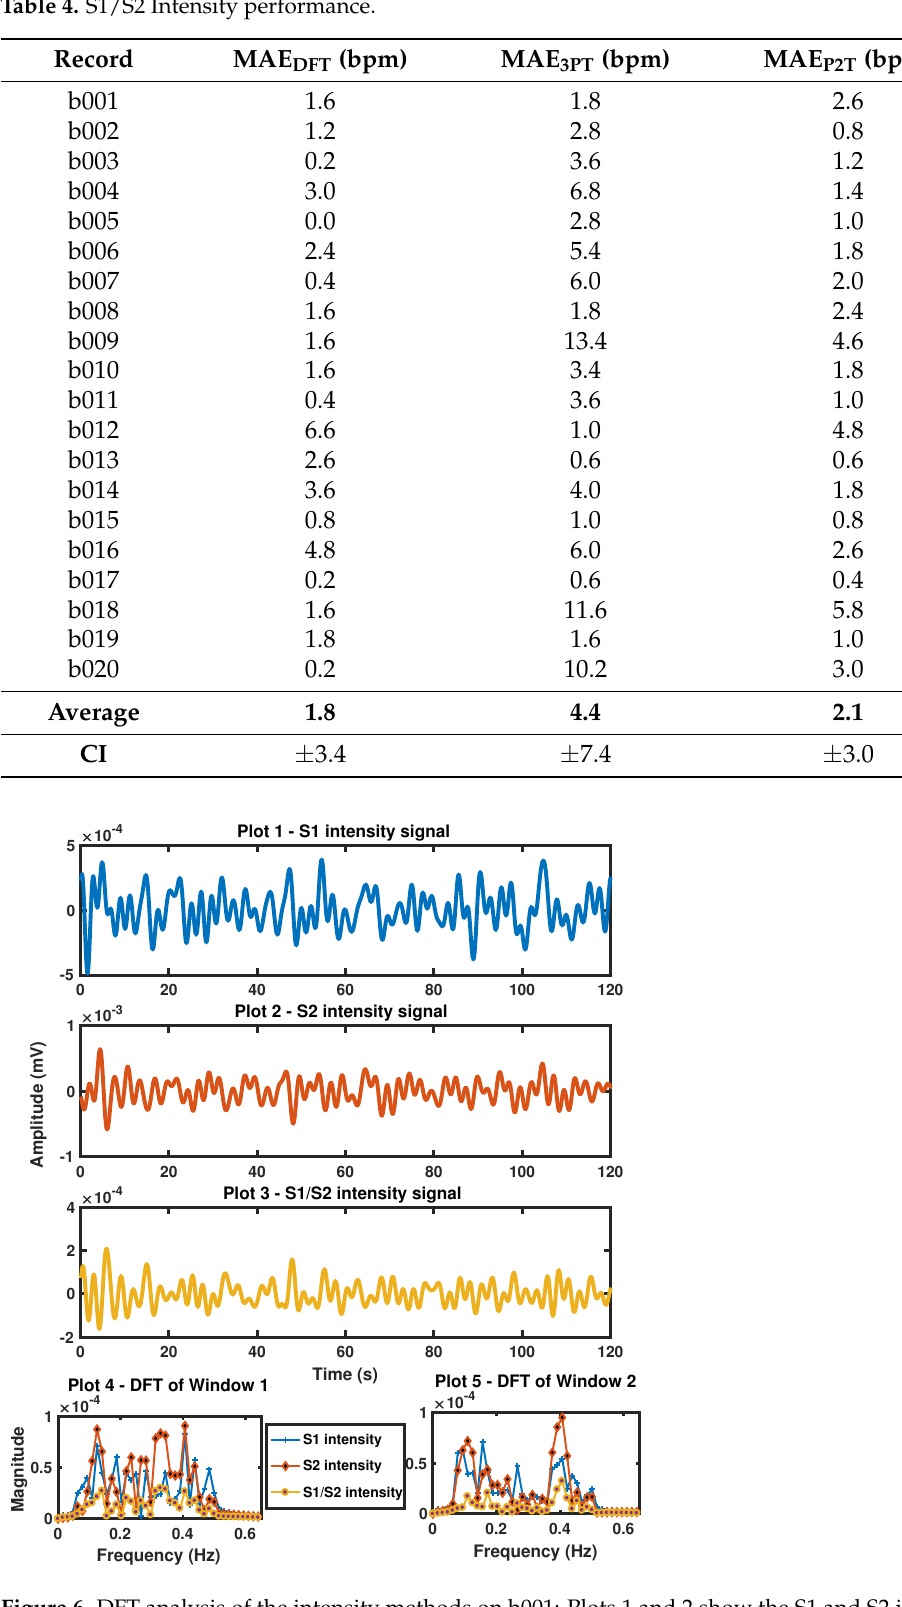
Figure 6. DFT analysis of the intensity methods on b001: Plots 1 and 2 show the S1 and S2 intensity signals, respectively. Plot 3 depicts the S1/S2 intensity signal. Plot 4 shows the DFT analysis of the three methods for the first respiratory window, where Plot 5 gives the corresponding information for the second respiratory